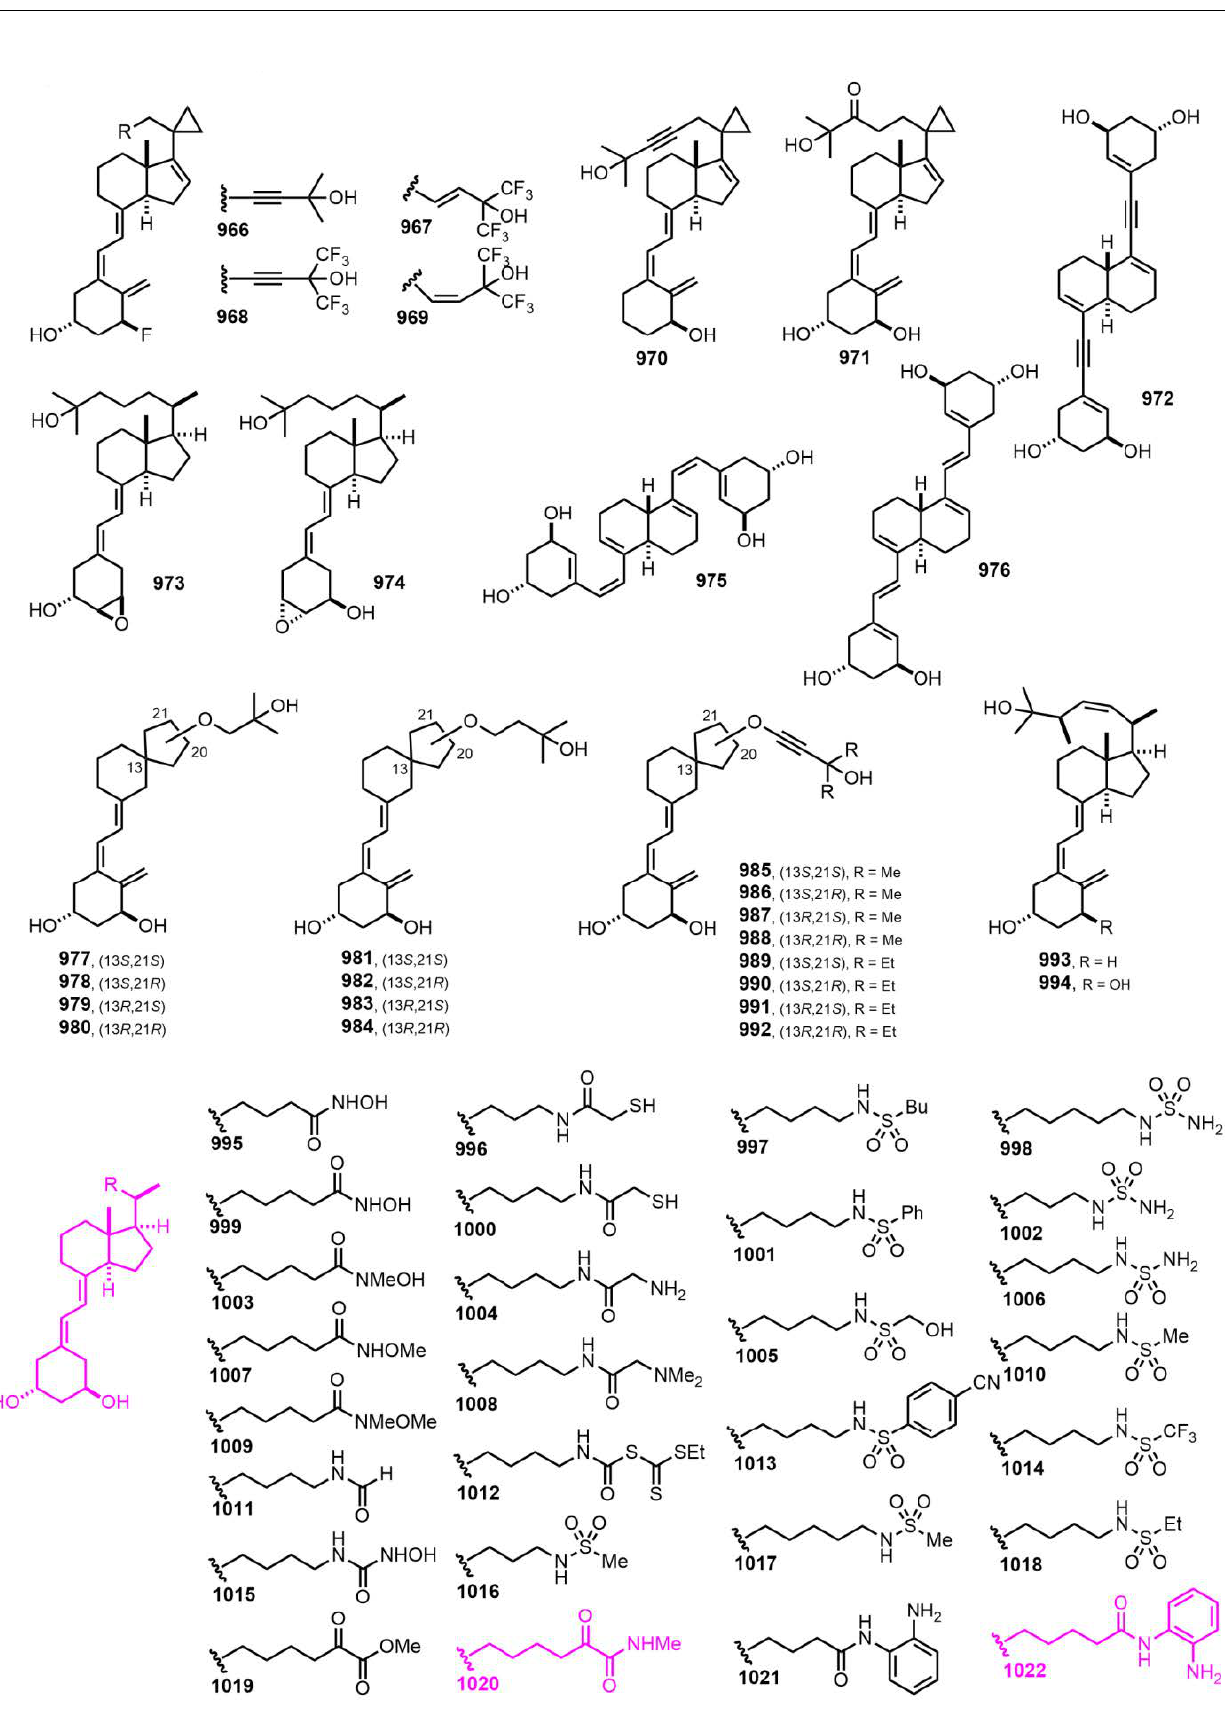
Figure 18. (2009–2010)